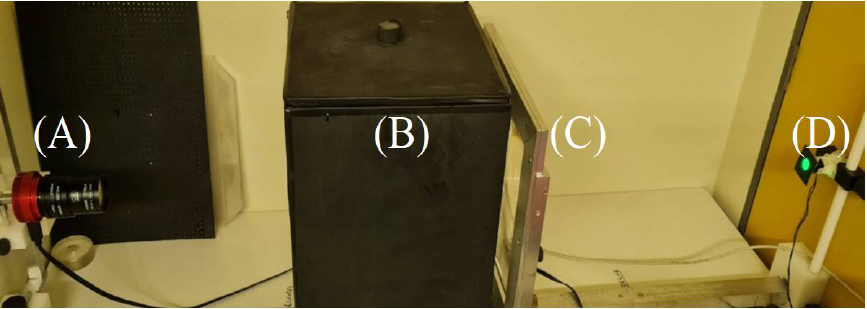
Figure 13. ( A ) ZWO ASI120mm-S camera; ( B ) Water tank; ( C )Fresnel lens and ( D ) 3W LED. The gel vial irradiation for the CSI matching field verification followed the CSI plan.